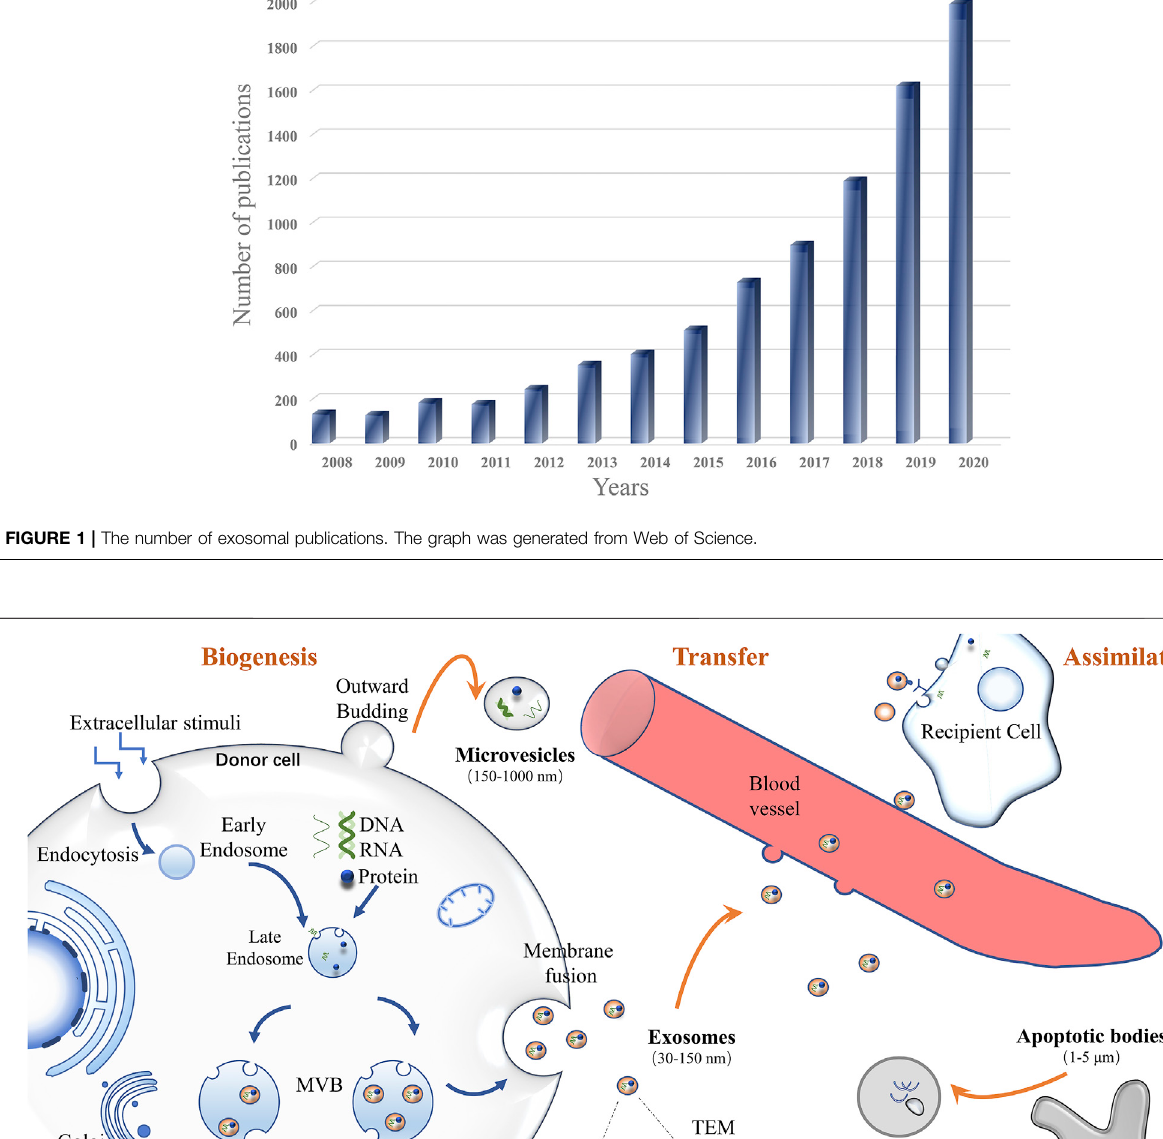
Frontiers in Bioengineering and Biotechnology |